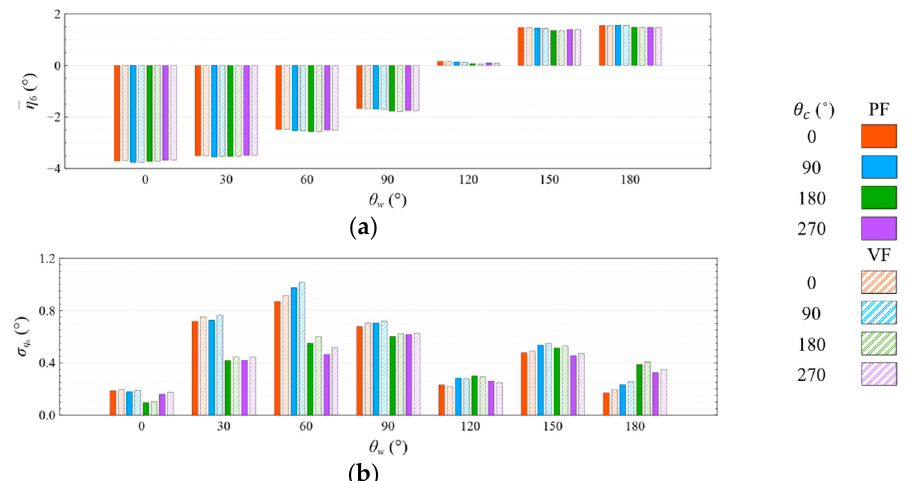
Figure 26. Comparison of ( a ) means and ( b ) standard deviations of platform yaw motion under HW condition.